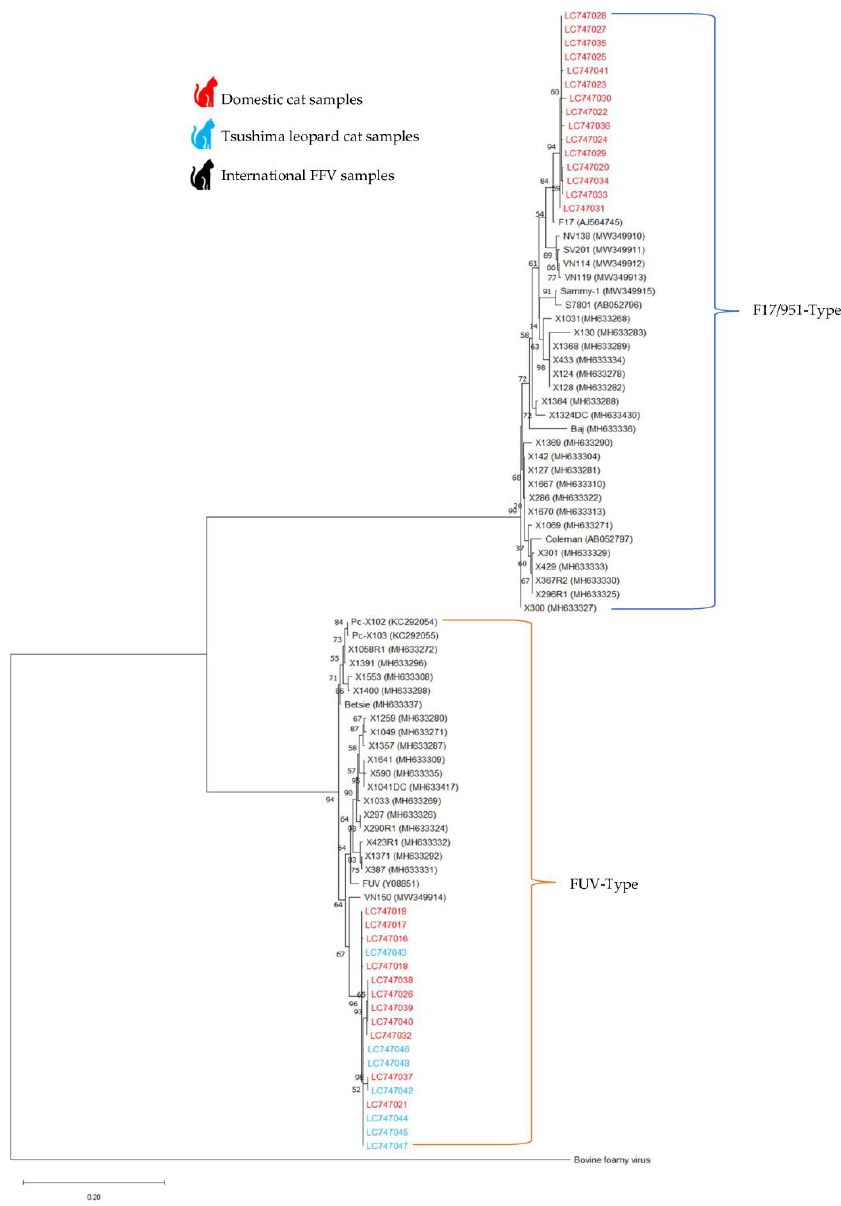
Figure 3. Maximum likelihood tree for SU region nucleic acid sequence. The percentage of replicate trees in which the associated taxa clustered in the bootstrap test (1000 replicates) are shown next to the branches. The tree is drawn to scale with branch lengths in the same units as those of the evolutionary distances used to infer the phylogenetic tree. The evolutionary distances were computed using the Kimura 2-parameter method and are in the units of the number of base differences per site. This analysis involved 84 nucleotide